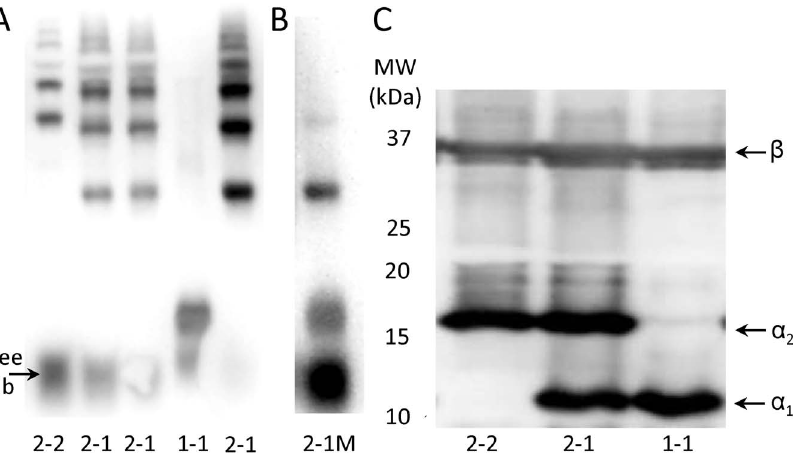
Figure 1. Hp phenotypes by Native and SDS PAGE. Panel A: Hp phenotyping of Hb-supplemented serum by Native PAGE on a 6% gel. Hp 2-2 (Lane 1) is a heterodimer with a series of slow moving bands. Hp 1-1 (Lane 4) is a homodimer with one fast moving band. Hp 2-1 (Lanes 2, 3, 5) has a band between the Hb/Hp 1-1 and Hb/Hp 2-2 bands, and several slow-moving bands in the same region as the Hb/Hp 2-2 bands. Panel B: In the rare Hp 2-1 M phenotype, a modification of the Hp a 2 allele leads to overproduction of the fast migrating Hp 1-1 band, relative to the slower migrating Hp 2-1 bands. This results in a stronger Hb/Hp 1-1 band, and weaker Hb/Hp 2-1 bands, than in Hp 2-1. Panel C: Hp phenotyping of serum by SDS PAGE on a 12% gel. The Hp b band is common to all phenotyes. The presence of the Hp 1 and 2 alleles is indicated by the a 1 and a 2 bands, respectively.